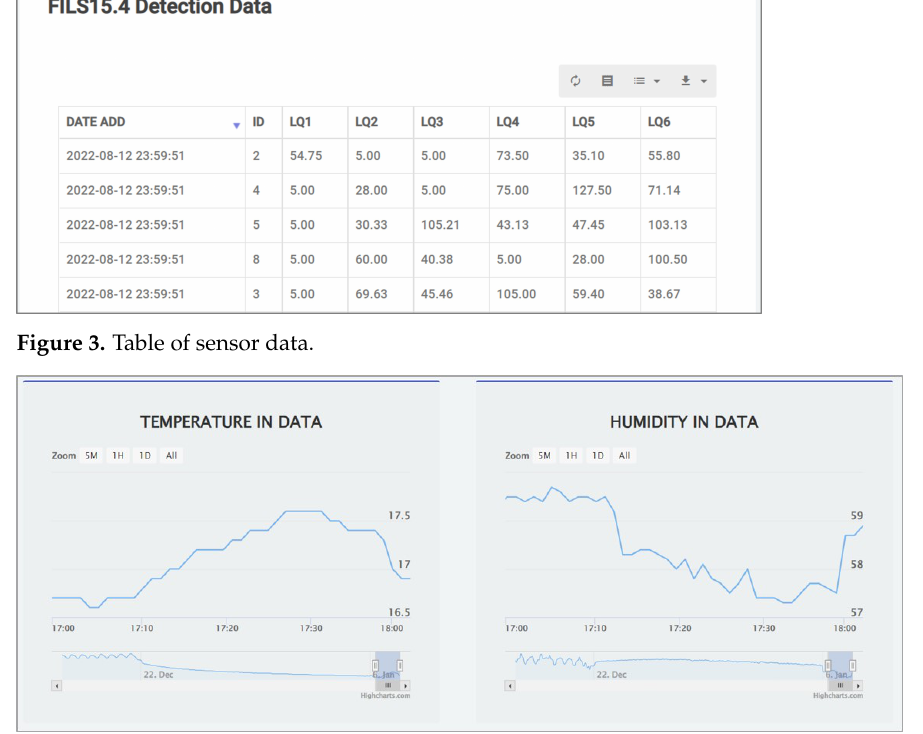
Figure 4. Graphs of sensor data.